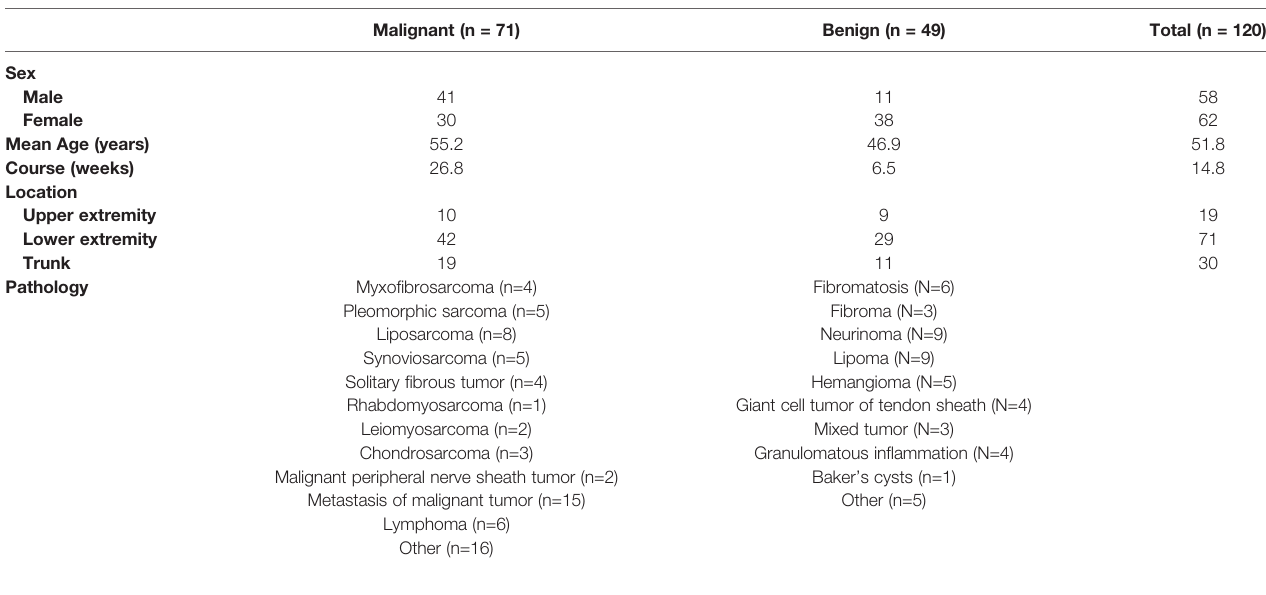
TABLE 1 | Pathological diagnosis of the patients in the present